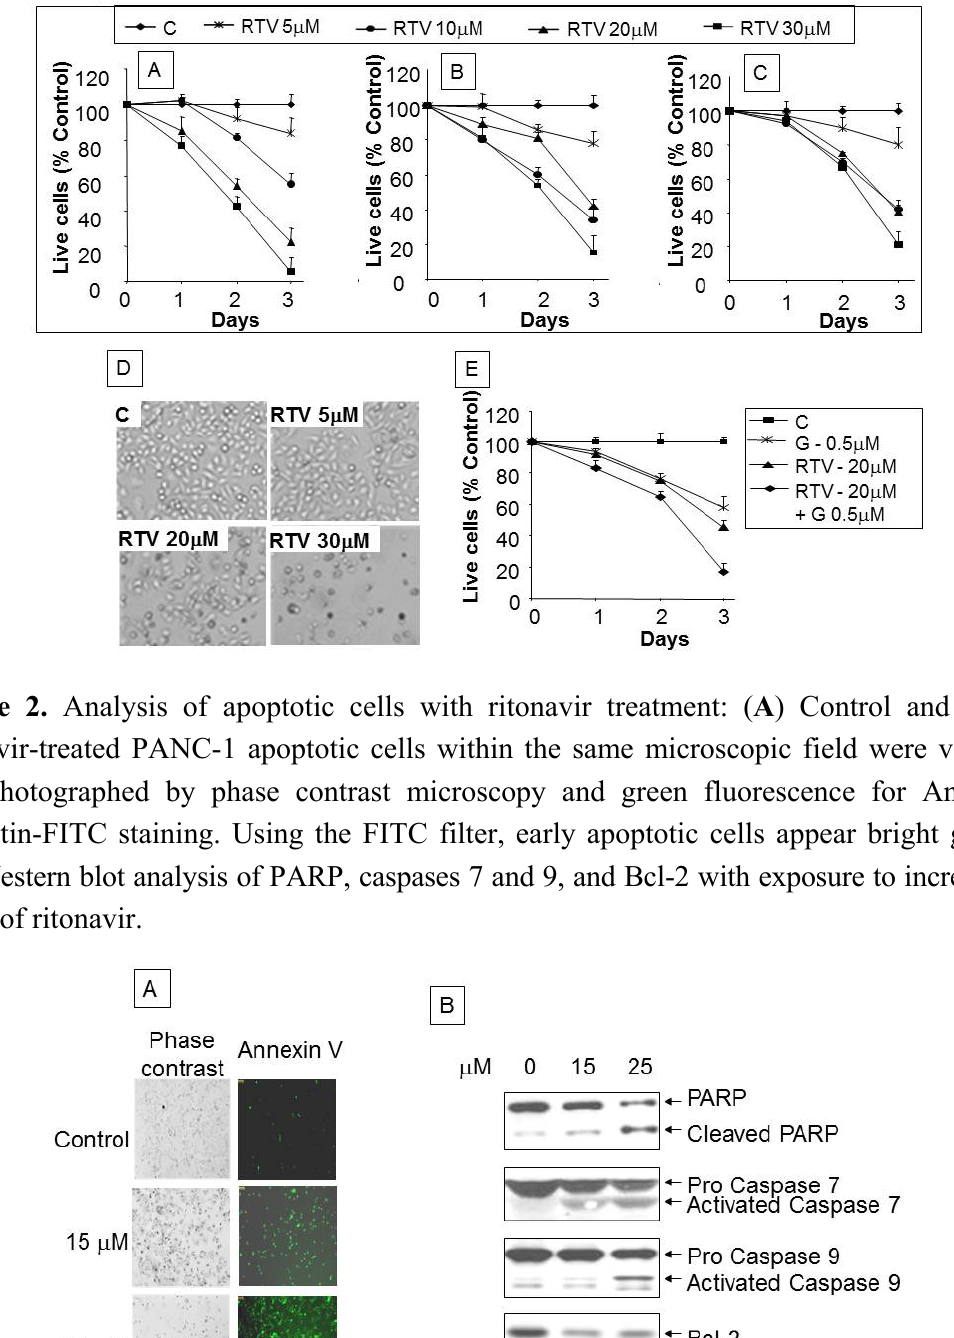
Figure 1. Effect of ritonavir on the growth of pancreatic cancer cell lines with enhanced killing of PANC-1 cells in combination with gemcitabine: Cells were cultured for indicated time intervals with various concentrations of ritonavir. ( A ), ( B ) and ( C ) are BxPC-3, MIA PaCa-2, and PANC-1 cell lines, respectively. Data is presented as percentage of control DMSO-treated cells and represents the mean ± SD of triplicate cultures; ( D ) Phase contrast images taken at 100× magnification 48 h after ritonavir treatment of PANC-1 cells at indicated concentrations; ( E ) Gemcitabine-mediated cytotoxicity of PANC-1 cells with or